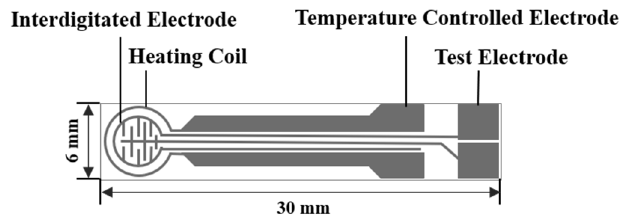
Figure 1. The schematic diagram of the TC-5010 sensor substrate.